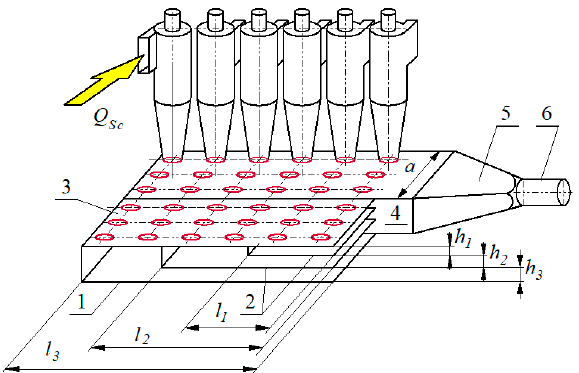
Figure 8. Schematic division diagram of the settling tank into independent channels: 1—cyclone mounting plate, 2—settling tank bottom, 3—partitions, 4—vertical wall, 5—transition channel, 6—suction connector.